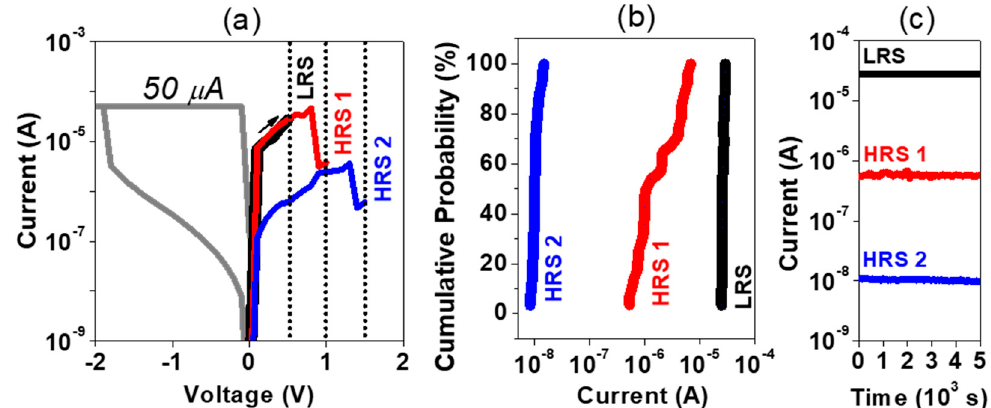
Figure 5. I–V sweeps of set at CC of 50 µA and reset to two distinct high resistance states (HRS), ( a ) with the corresponding distribution of resistance states ( b ) and retention over 5 × 10 3 s ( c ).